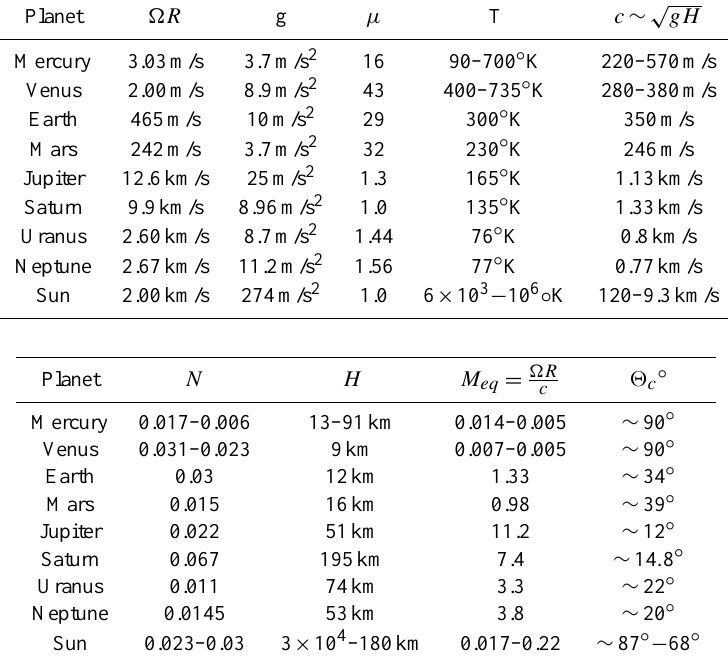
Table 1. Properties of the planets and the Sun required in the calculation of the stability condition and the critical latitude 2 c .